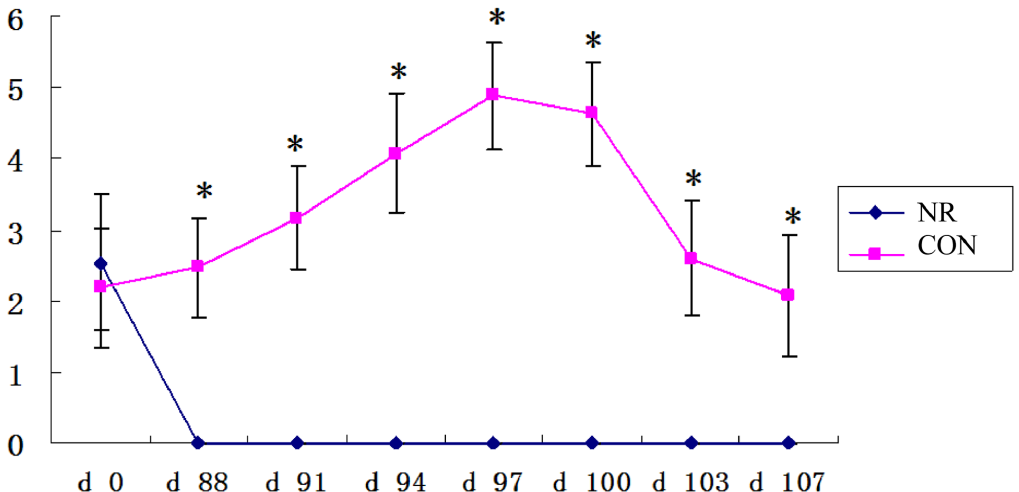
Fig 1. Concentrations of progesterone (P) in normal (CON) or nutrient-restricted (NR) gilts. CON denotes normally fed gilts (2.86 kg/d) and NR denotes nutrient restricted gilts (1 kg/d). The day of the second occurrence of standing heat was designated as d 0. P, progesterone; E2, estradiol. * denotes P < 0.05. n =